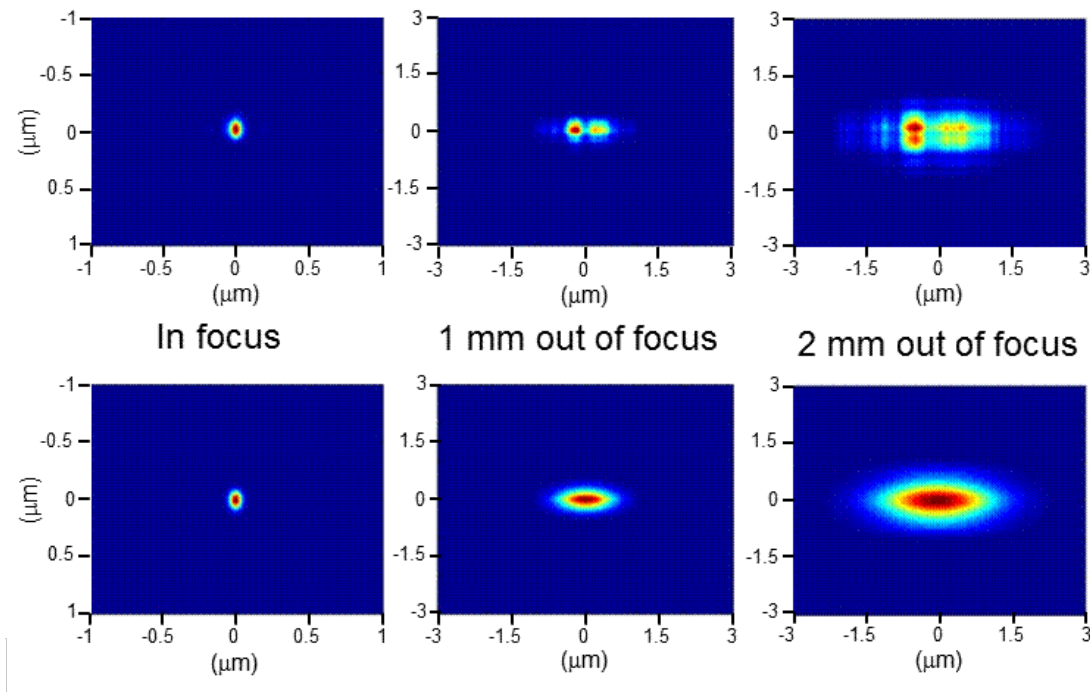
Figure 1. Effect of mirror shape errors on the spot in-focus and away from the focus. The three upper pictures are for a system of four mirrors, with a combined Strehl ratio of 0.8. The lower three figures are for a Strehl Ratio (SR) of